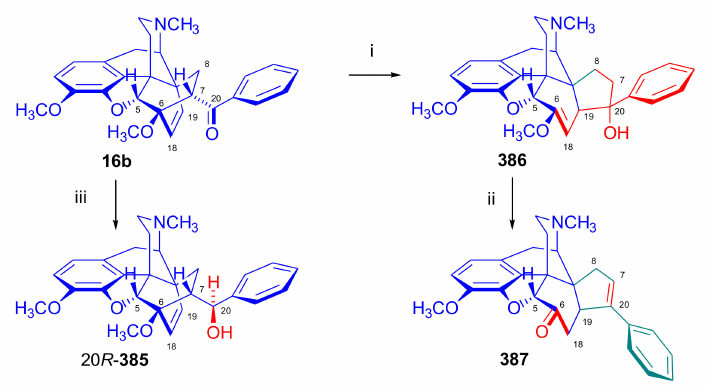
Figure 98. Reaction of nepenthone with chromium(II) reagents in aqueous medium. Reagents and con- ditions : (i): from nepenthone bitartrate (1 mmol), ethylenediaminetetraacetate (EDTA, Na 2 EDTA · H 2 O, 2.2 mmol), KOH (OH − : 3.34 mmol), water, [Cr(OAc) 2 · H 2 O] 2 (1 mmol, 2 mmol CrII), pH = 5.2, argon, 18 h, 62%; (ii): 3% hydrochloric acid, reflux, 3 h, 96%; and (iii): from nepenthone bitartrate (1 mmol), iminodiacetate (IDA, 4 mmol), KOH (OH − : 5.57 mmol), water, [Cr(OAc) 2 · H 2 O] 2 (1 mmol, 2 mmol CrII), pH = 6.1, argon, 18 h, 86%.